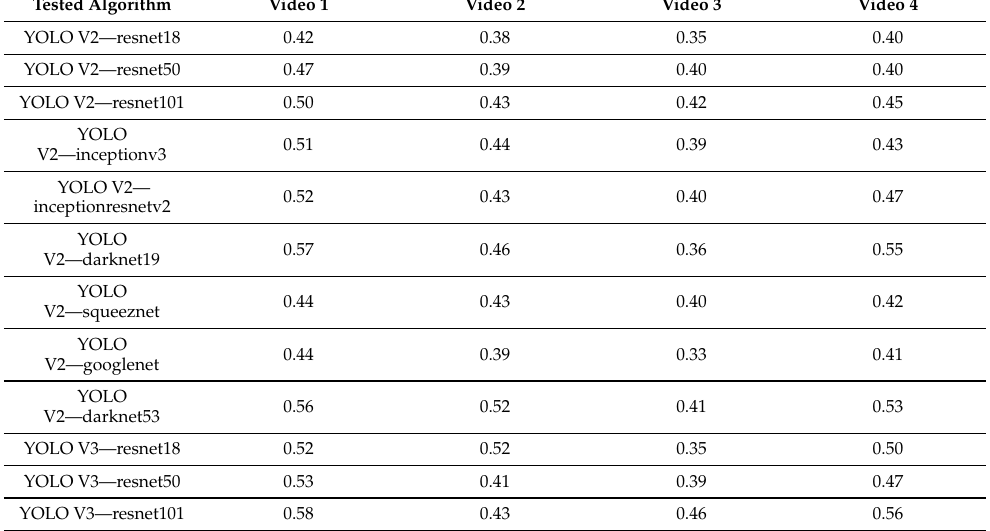
Table 23. Average precision for tested techniques. Tested